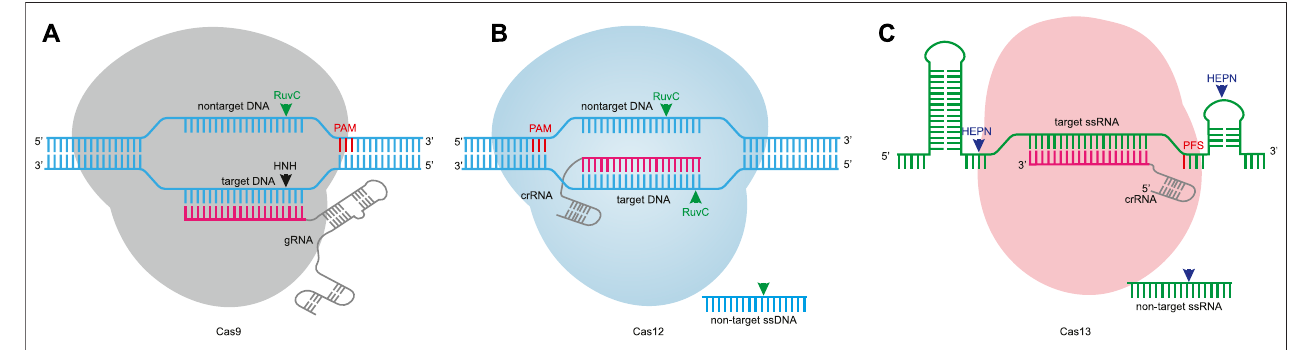
FIGURE1| Nuclease-mediated editing. (A) . Cas9 nuclease isguided by gRNA fortargetingspeci fi city. Theprotospaceradjacent motif (PAM) sequence islocated 3 ′ of the nontarget DNA. The Cas9 nuclease domains, RuvC and HNH, cleave the nontarget DNA and target DNA to induce predominantly a blunt DSB. (B) . Cas12 nuclease recognizes DNA target sequences with crRNA. The PAM motif is located 5 ′ of the nontarget DNA, and the RuvC-like nuclease domain cleaves both strands of DNAtogenerateastaggered DSB. Inparallel, atargetDNAcanactivatecollateralcleavage activity tocleave non-targetssDNAthroughcorrectbase-pairingtothe crRNA. (C) . Cas13 proteins are crRNA-guided RNA-targeting nucleases, some of which require protospacer fl anking sequence (PFS). The two HEPN domains cleave the target ssRNA. Analogous to Cas12, Cas13 also exhibits collateral cleavage activity to cleave non-target